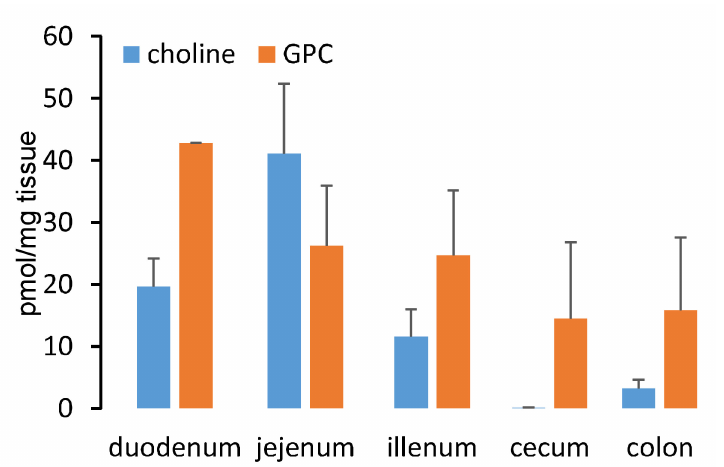
Figure 4. GPC is abundant in the gut. GPC and choline distribution in the mouse gut. Four female C57BL/6J mice were sacrificed and the gut was collected to quantify GPC and choline by LC-MS. Data are presented as mean ±